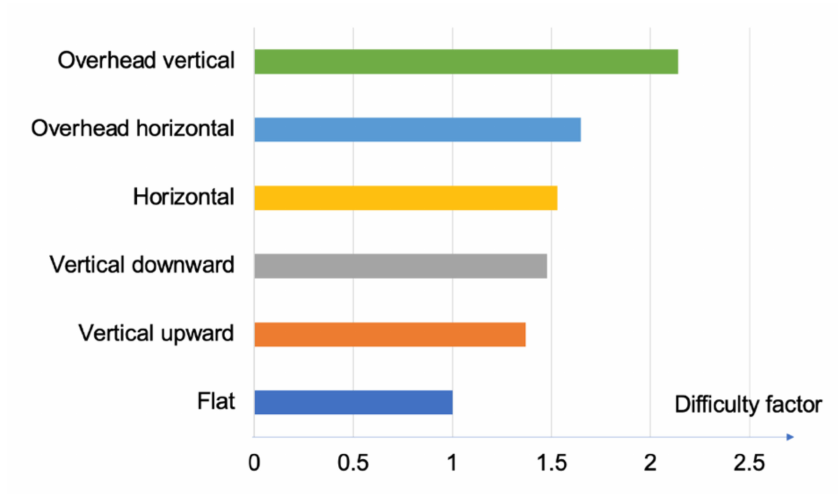
Figure 12. Difficulty factors by the proposed method.